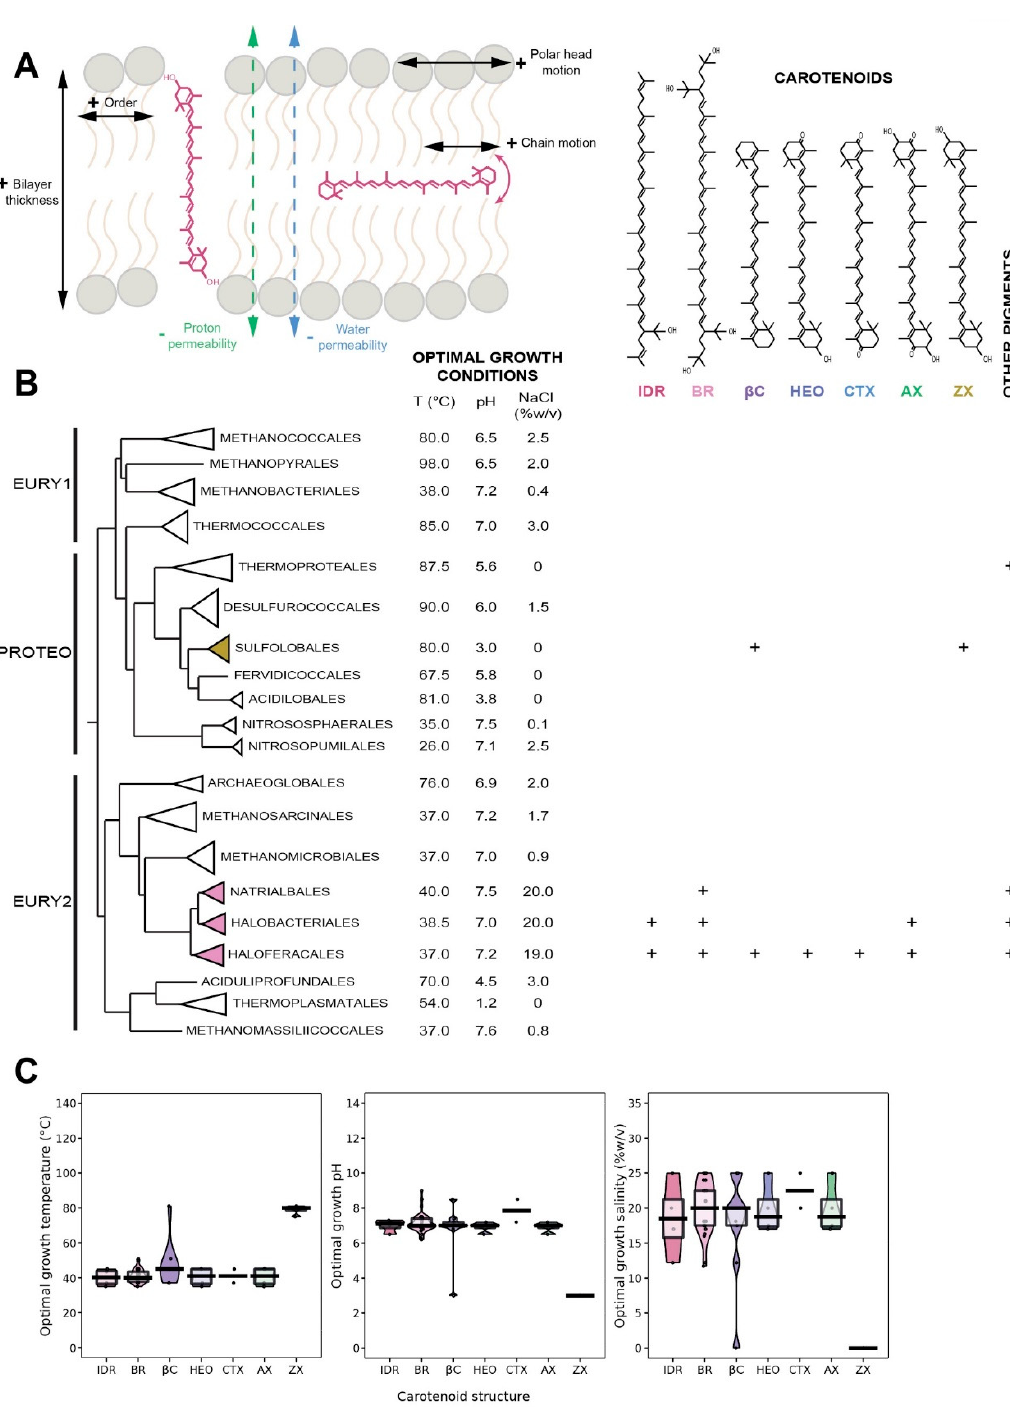
Figure 2. Physicochemistry, distribution and adaptive response of carotenoids in Archaea. ( A ), Position and impacts of carotenoids on membrane physicochemical properties. ( B ), Structures and distribution of carotenoids within the Archaea domain. The tree topology has been adapted from [34]. ( C ), Pirateplot of the optimal growth conditions of the organisms in which the different types of carotenoids were detected. Colors indicate the chain lengths as in B. Abbreviations: IDR, isopentenyldehydrorhodopin; BR, bacterioruberin; BC, β -carotene; HEO, 3-hydroechinenone; CTX, canthaxanthin; AX, astaxanthin; ZX, zeaxanthin. EURY1, Euryarchaeota cluster I; PROTEO, Proteoarchaeota; EURY2, Euryarchaeota cluster II.